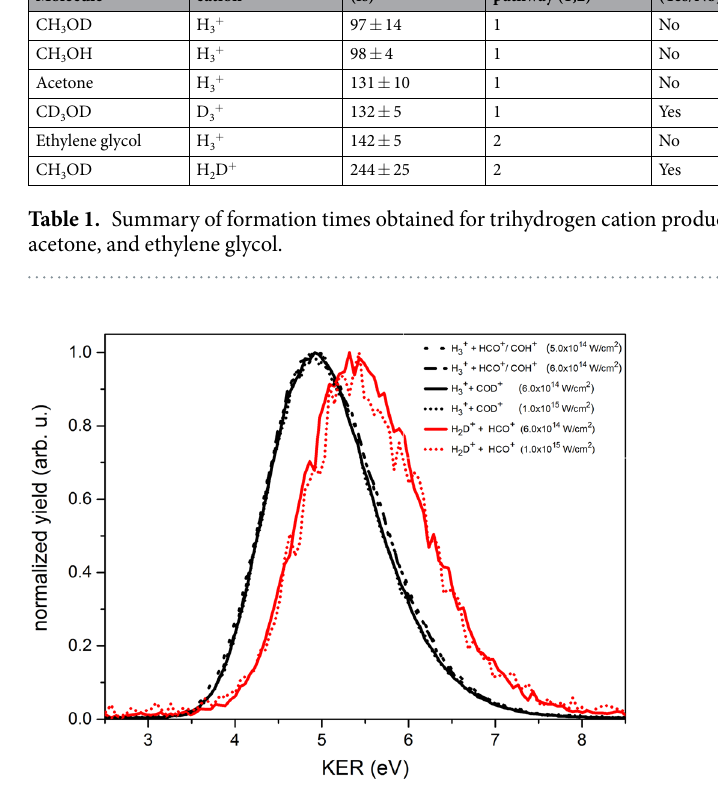
Figure 8. Kinetic energy release (KER) during the formation of trihydrogen cations at different focal intensities for dissociative ionization of CH 3 OH and CH 3 OD. All H 3 + formation channels (black curves) represent a Gaussian distribution with a mean of 5.00 eV and a standard deviation of 0.62 eV, while H 2 D + formation channels (red curves) have a similar distribution with a mean of 5.48 eV and a standard deviation of 0.69